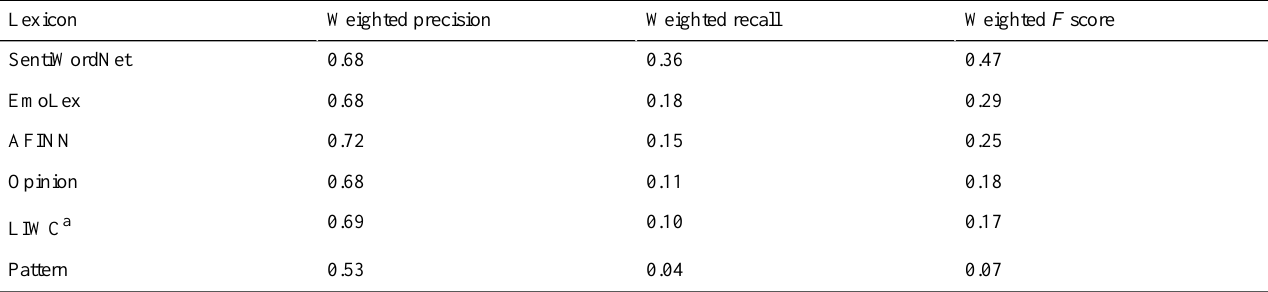
Table 7. Weighted metrics for each lexicon in descending order of weighted F